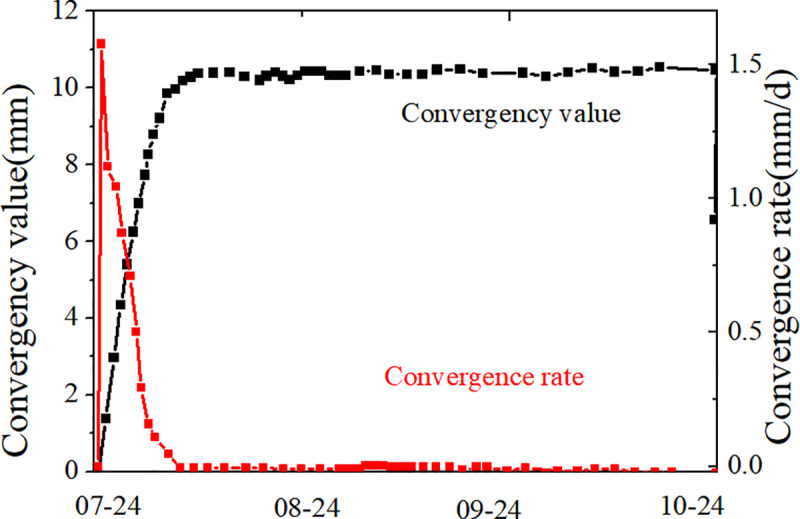
Curve of convergence and convergence rate of CD side of portal.